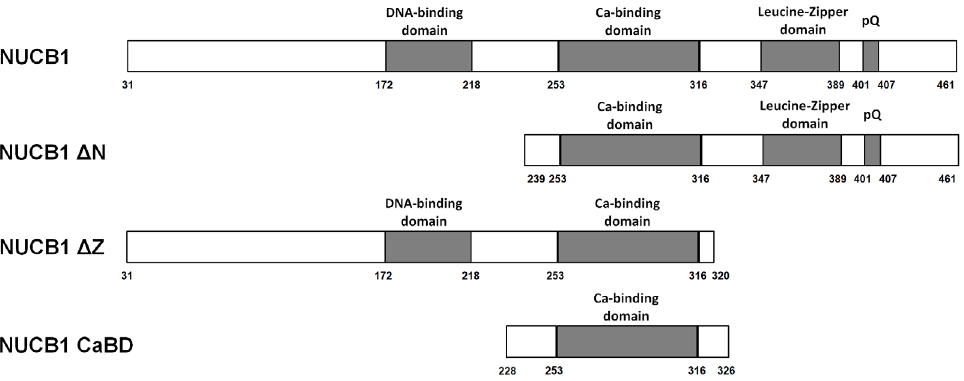
Figure 3. Schematic representation of NUCB1 and its truncated forms.